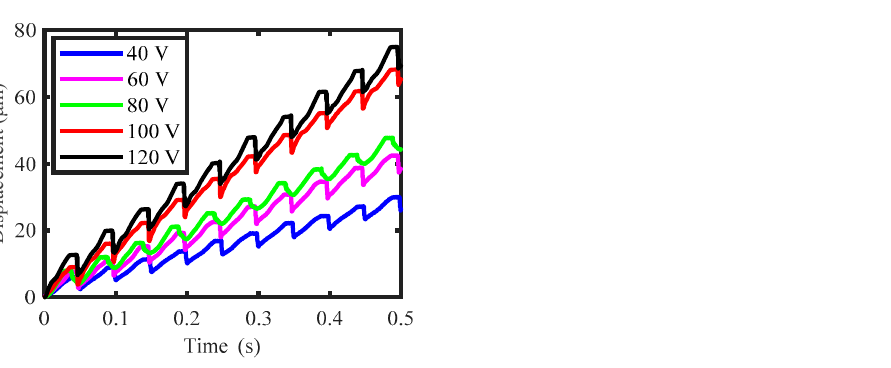
Figure 19. Output displacement of the slider working under the normal stick-slip driving principle.